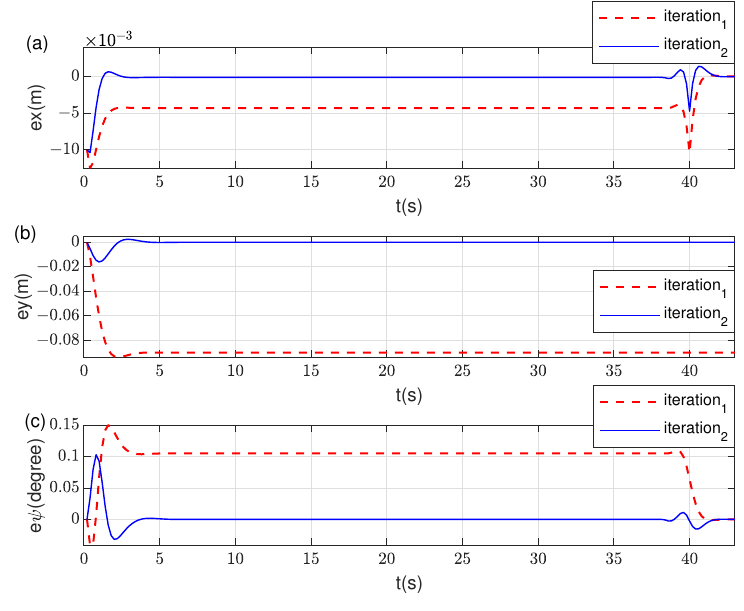
Figure 15. Tracking error under constant wind speed, water flow disturbances, model mismatch, and transient disturbances: ( a ) longitudinal error; ( b ) lateral error; ( c ) heading angle